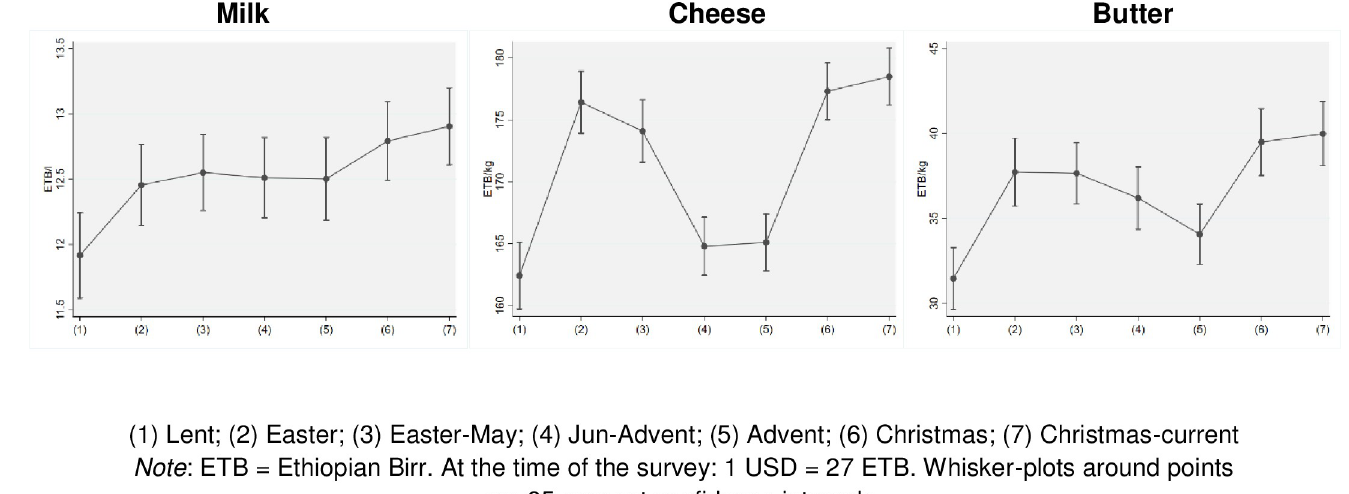
Fig 2. Average market prices of different dairy products throughout the year.